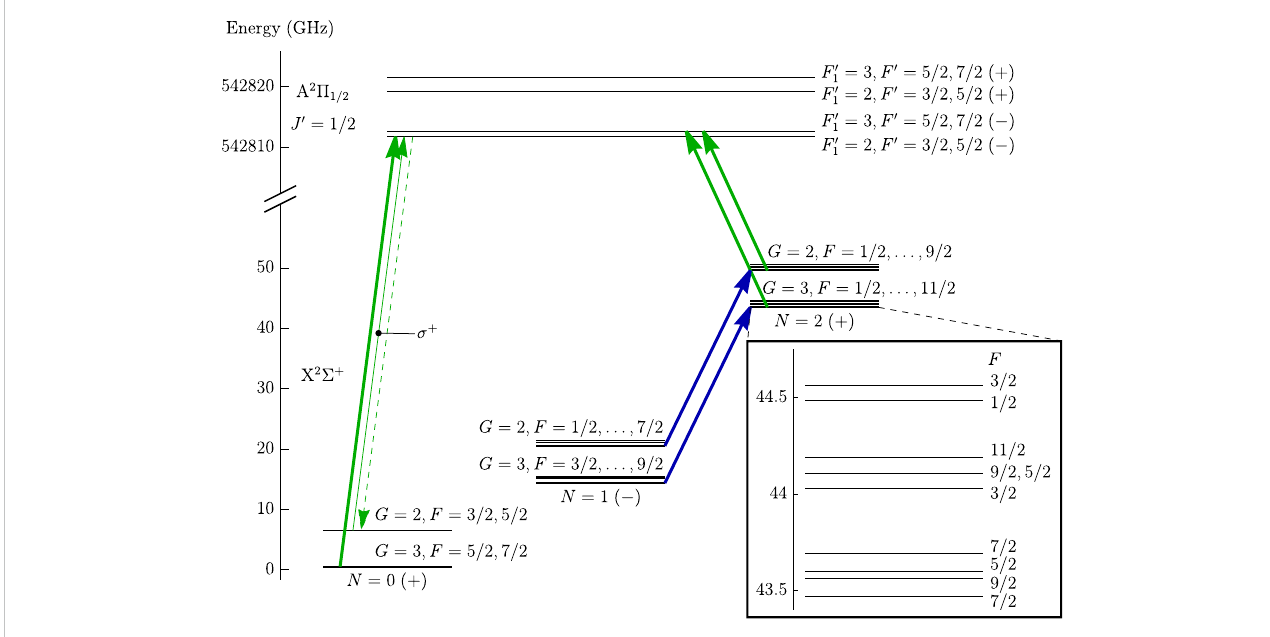
FIGURE 3 Optical pumping scheme for 173 YbF molecules. Thick green arrows denote transitions driven using polarization-modulated light. The thin green arrow denoteslightthatdrivesonly σ + transitionsfromthe G =2manifoldof N =0.Thetargetstate,| N =0, G =2, F =5/2, M F =5/2 〉 ,istheonlydarkstate.Microwave transitions (blue arrows) can also be driven in order to bring population from N = 1 to the target state. The inset shows the hyper fi ne structure within N = 2, G = 3.